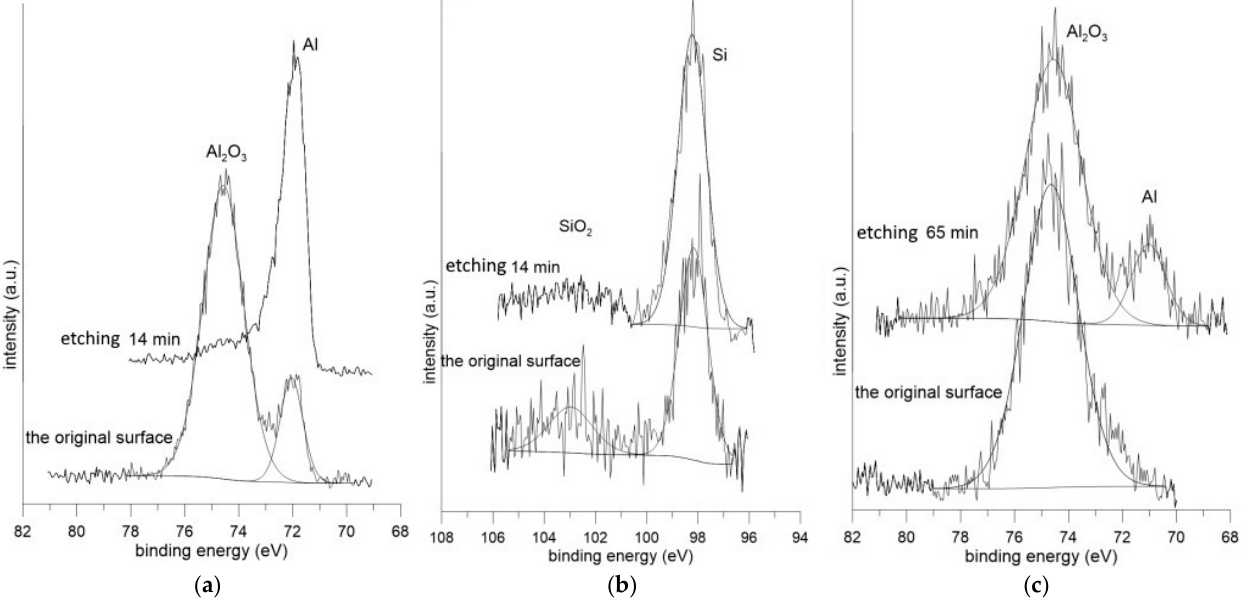
Figure 13. XPS spectra of ( a ) and ( b ) the Al-Si hot-dipped coating on as-received 22MnB5 boron steel and ( c ) the Al-Si coating on the die-quenched 22MnB5 boron steel.